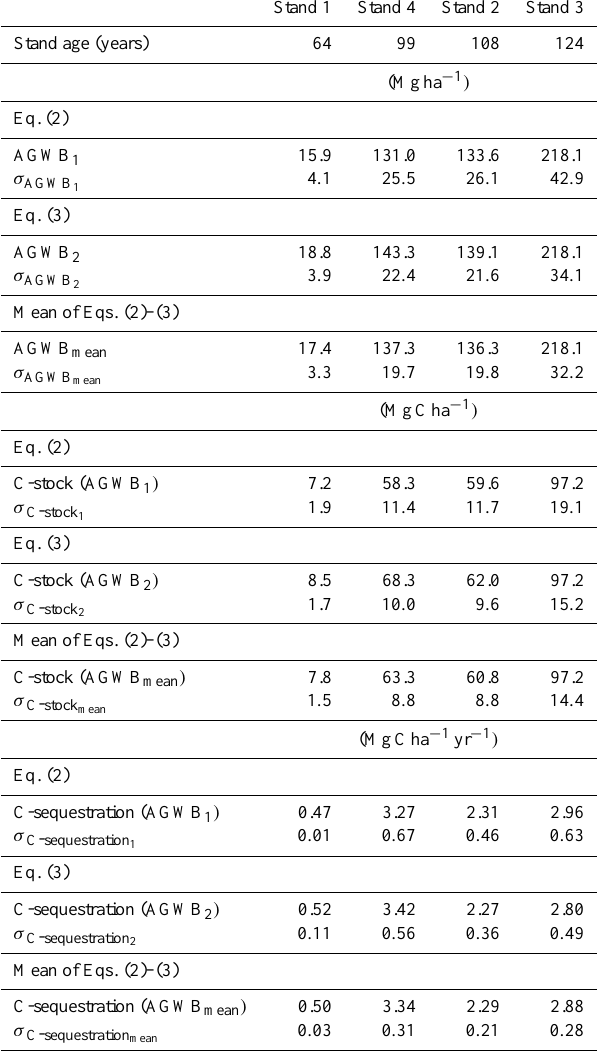
Table 3. Estimated AGWB, Carbon stocks and C-sequestration pro- jected by allometric Eqs. (2)–(3) in four stands of wetland forests in the Northern Pantanal. The propagation of measurement errors is indicated by standard errors.